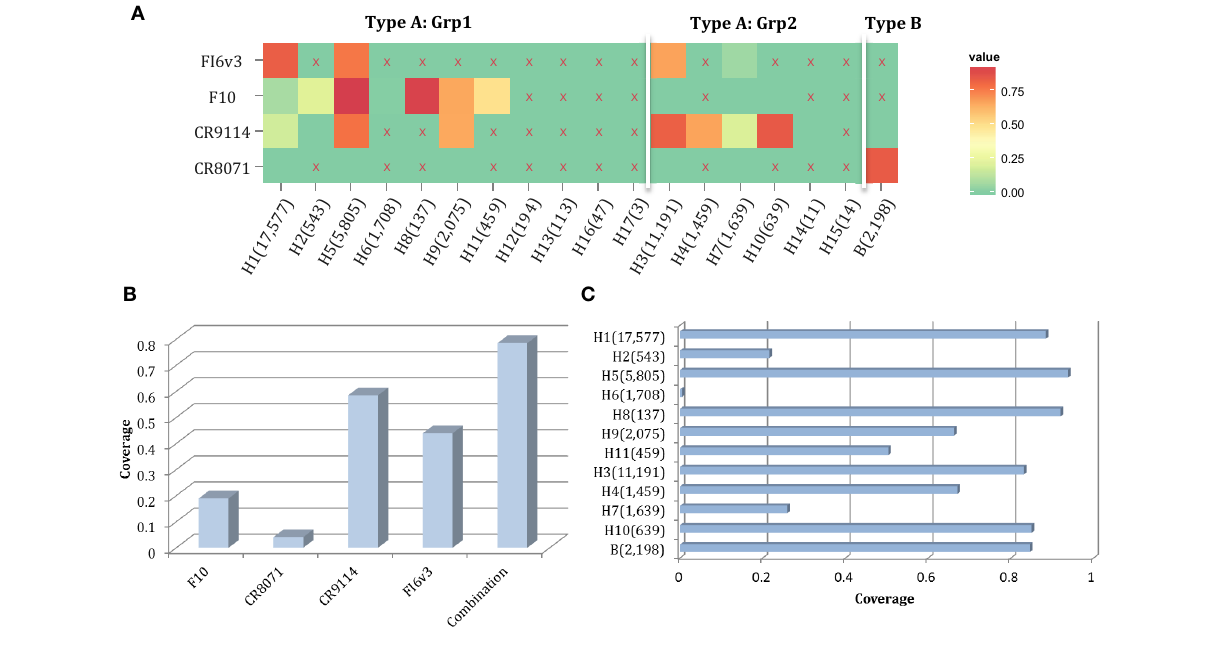
FIGURE 9 |A combination of four neutralizing subtype-diversified and potent neutralizing antibodies . (A) The heat map of the neutralized result for four nAbs, the color scheme is same as Figure 8A ; (B) the neutralized coverage of four nAbs individually, and the combination of